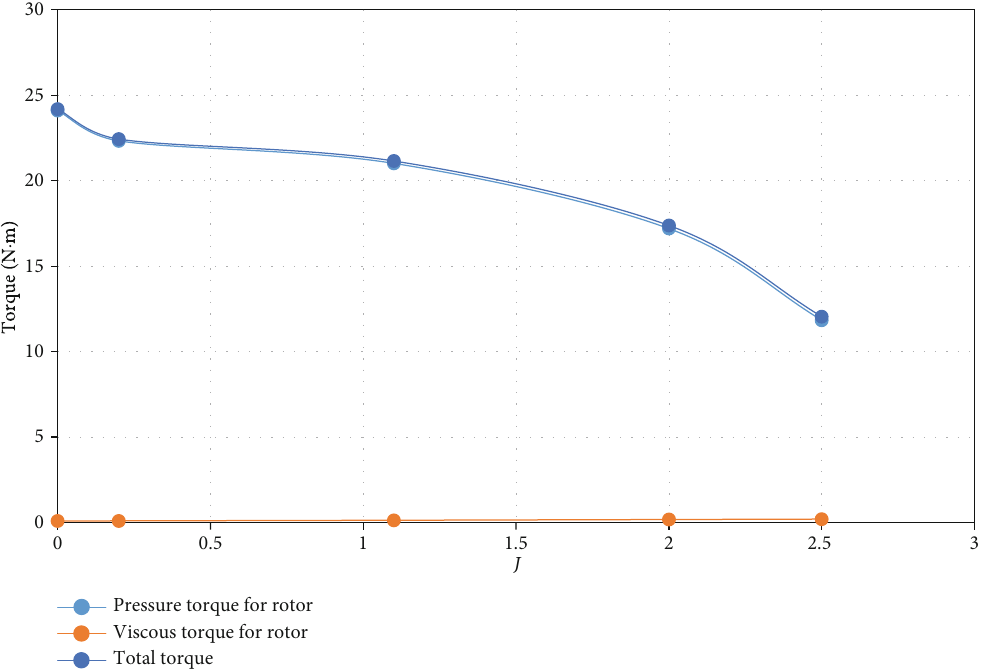
Figure 12: Torque force calculated for the linear jet system without a